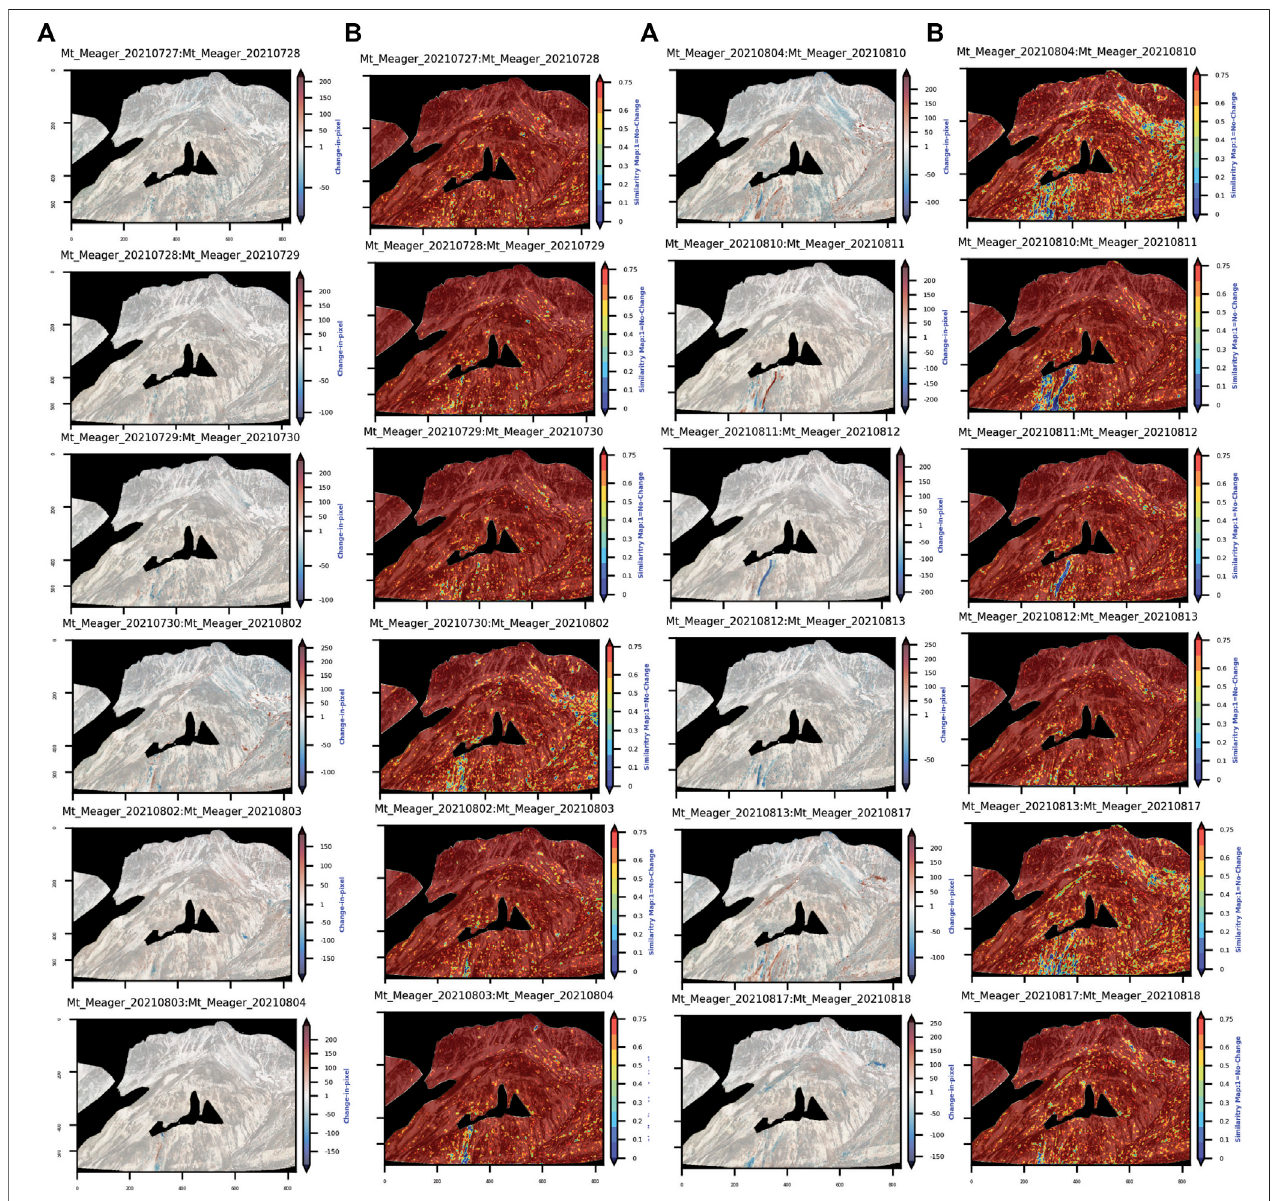
FIGURE 5 | Static change detection timestamp results for the Plinth Peak slope. Column (A) shows the image difference results, with negative values indicating areaswithmaterialbeingremovedandpositivevaluesbeingadded.Column (B) showstheStructuralSimilarityIndexMap,similaritymapscaledbetween0=nosimilarity and 1 = strongly similar (no